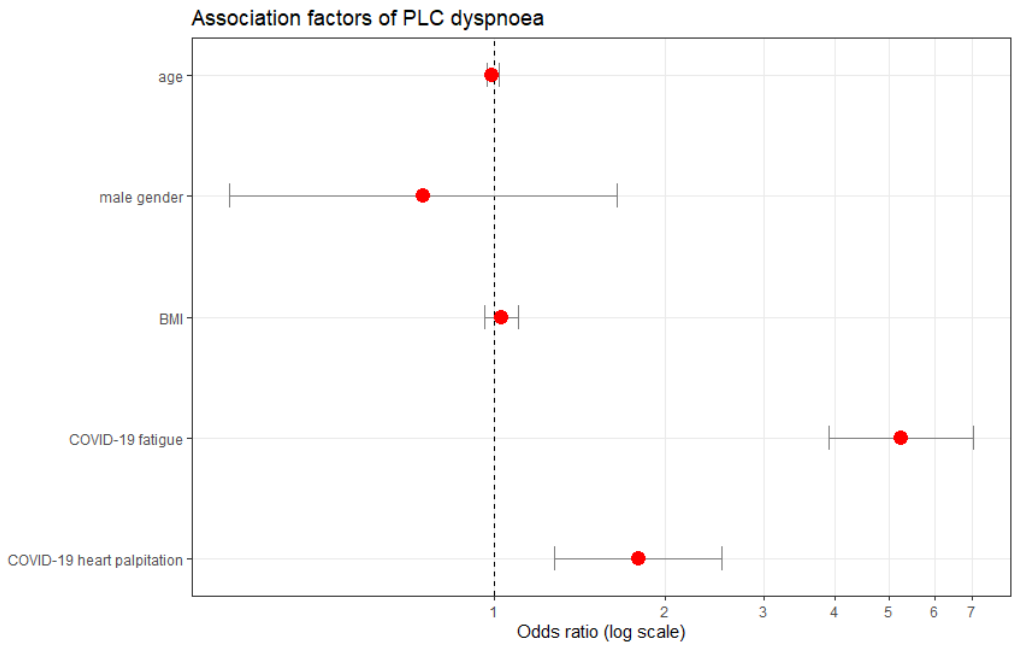
Figure 6. Probability of developing PLC dyspnoea, adjusted multivariable logistic regression analysis. Factors presented (except age, gender and BMI) are associated with a statistically significant ( p < 0.05) reduced probability (left-hand side from the indicated margin) or increased probability (right-hand side from the indicated margin) of developing PLC dyspnoea; PLC, post-acute COVID-19 syndrome; BMI, body mass index; red dots represent the probability (odds ratio) of developing PLC dyspnoea